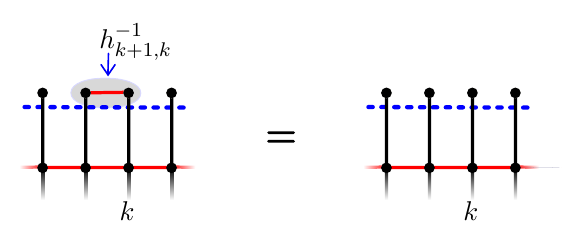
, removing the (cid:30) 2 propagator k +1 ;k